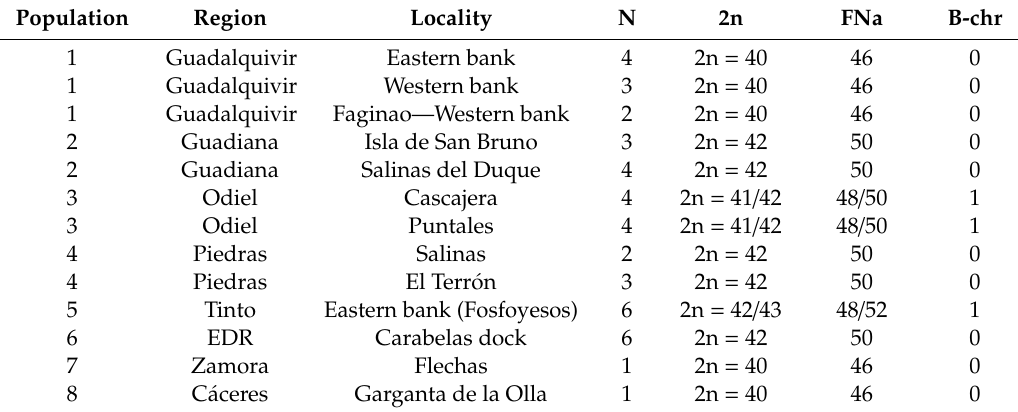
Table 1. Karyotype variants of Crocidura suaveolens found in the study area. Information includes population, region, locality, number of specimens (N), diploid chromosomal number (2n), autosomal fundamental number (FNa) and the presence of B-chromosomes